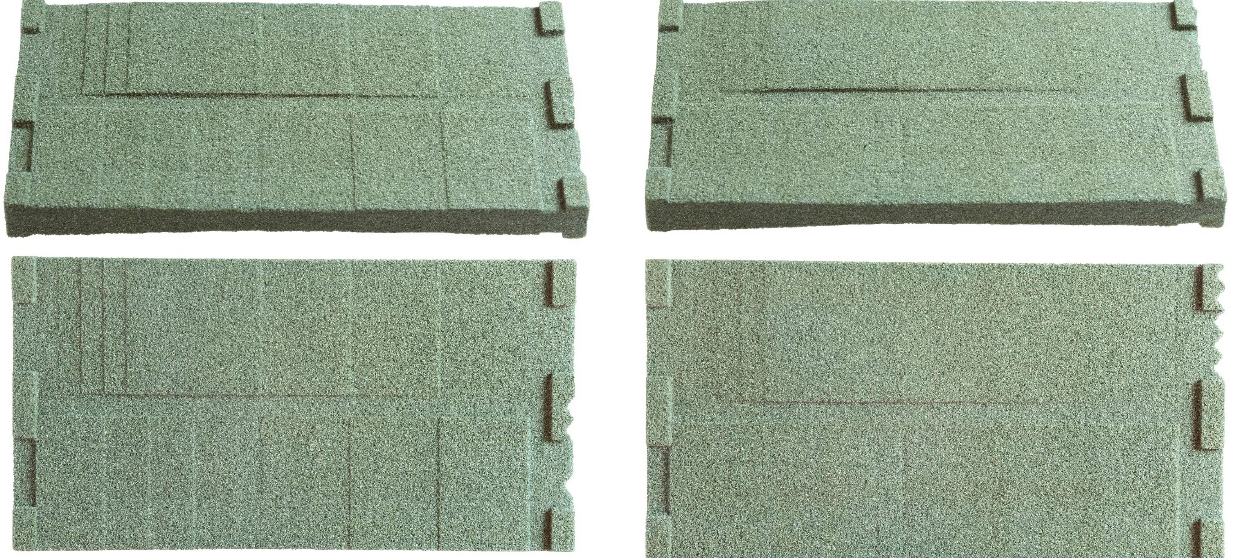
Figure 12. Two downskin perspectives on a conventionally printed part ( left ) and a smoothened part ( right ).